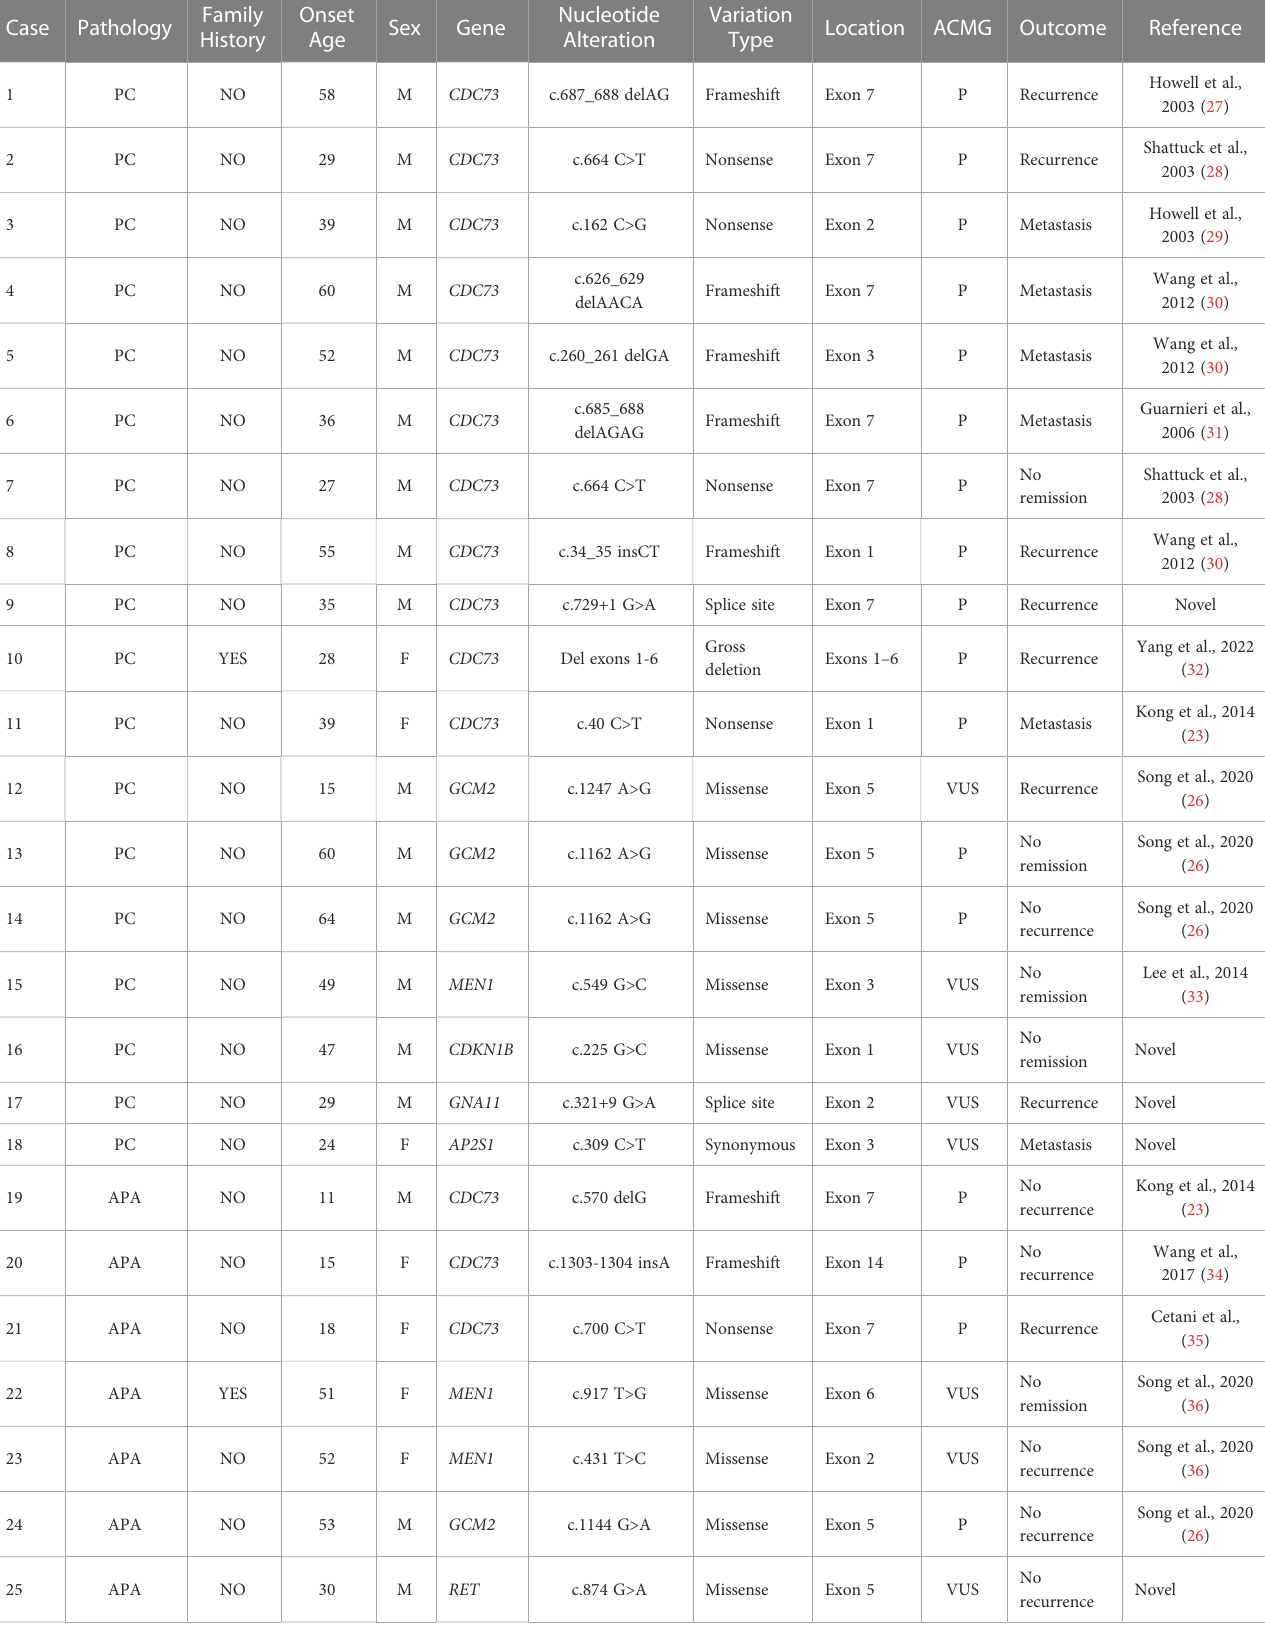
TABLE 3 Germline variants of candidate genes for primary hyperparathyroidism in studied APA and PC patients.